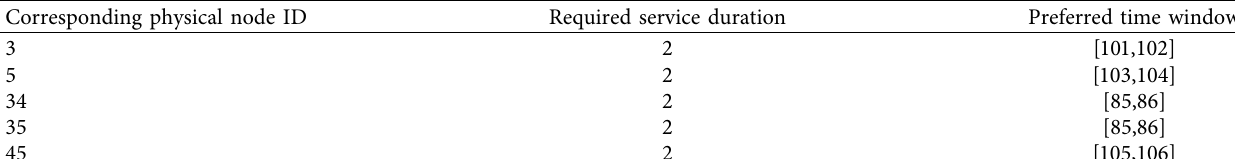
Table 13: Basic information of pick-up requests when τ � 80.